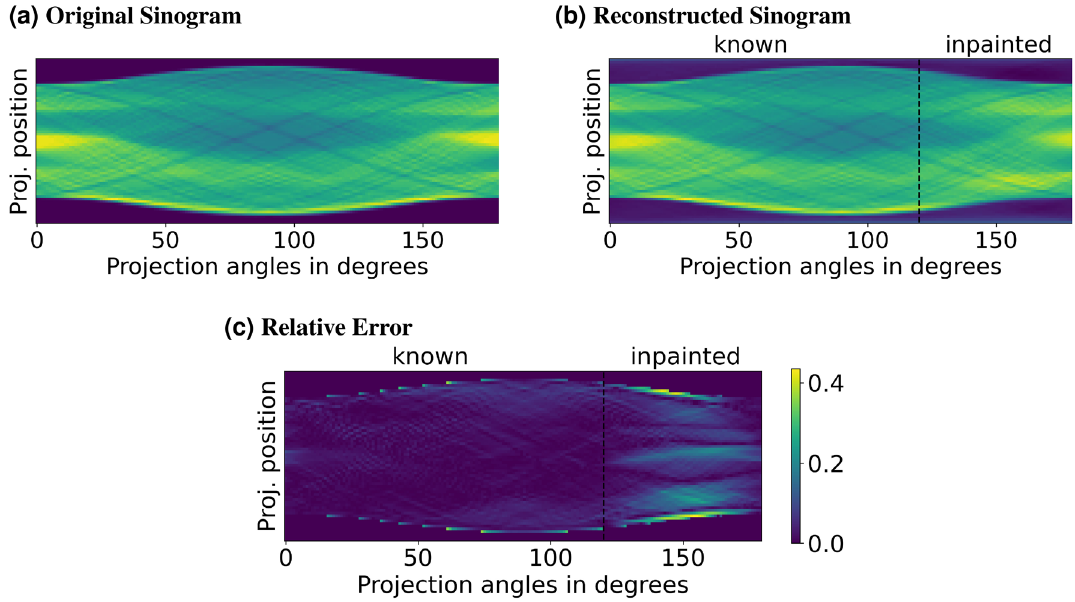
Figure 8. Reconstructed sinogram for noise-free 0 ◦ − 120 ◦ projections, the sinogram from the original object for Shepp–Logan phantom, and the relative error between